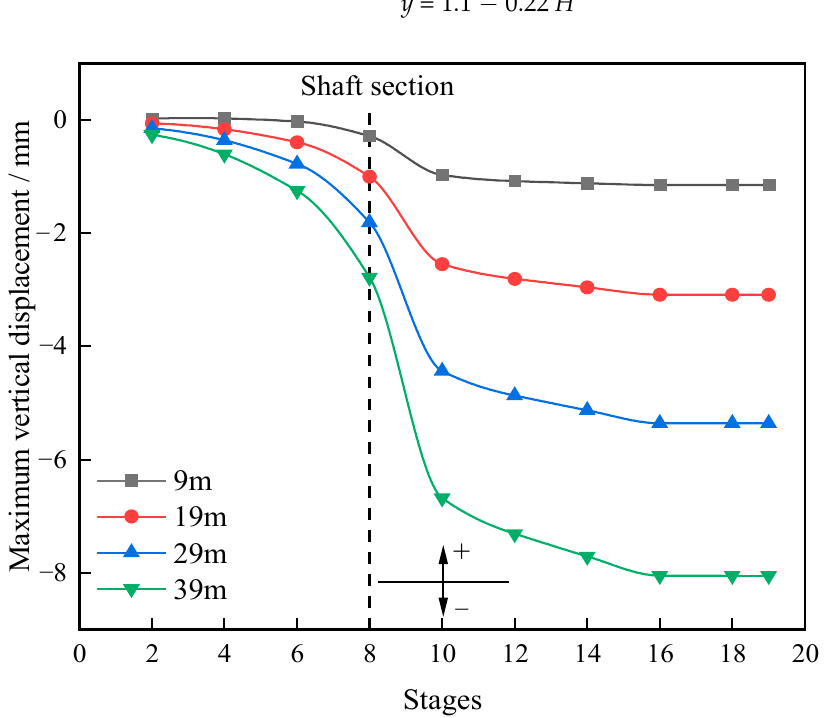
Figure 18. Vertical displacement curve of the tunnel vault.